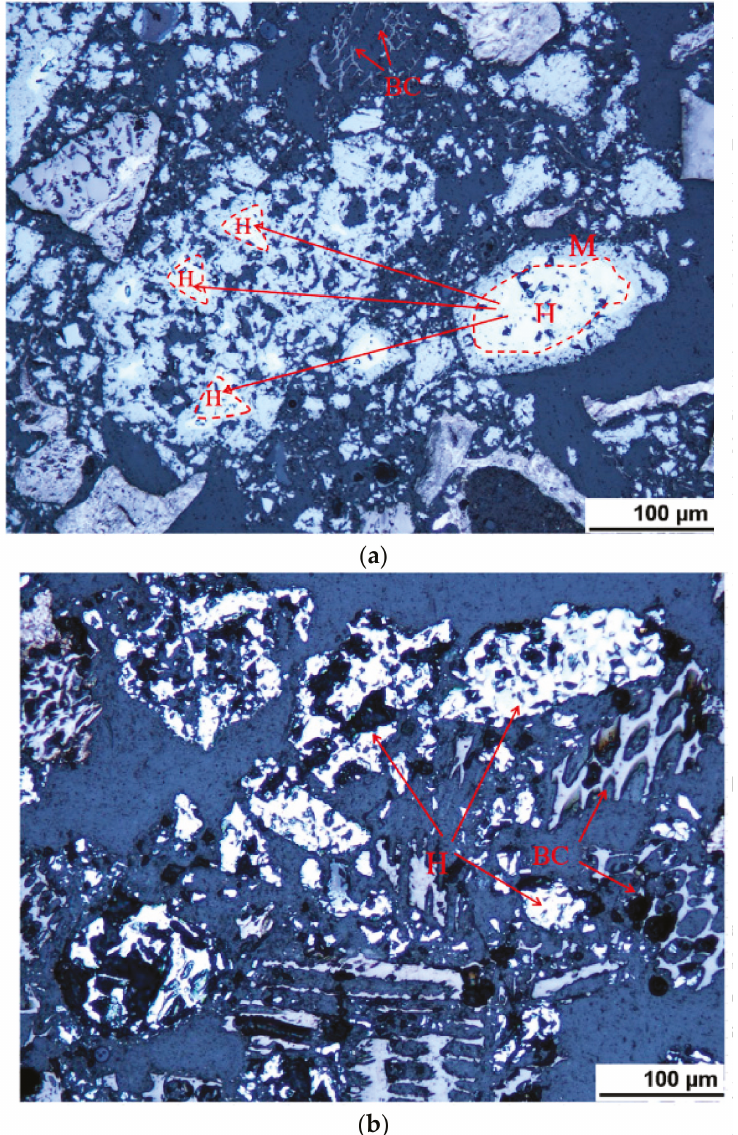
Figure 6. Typical textures observed in LOM (magnification 20x) in composites from tests interrupted at 680 ◦ C. ( a ) FRC and ( b ) CCC. H = hematite (white-grey), M = magnetite (grey) and BC =